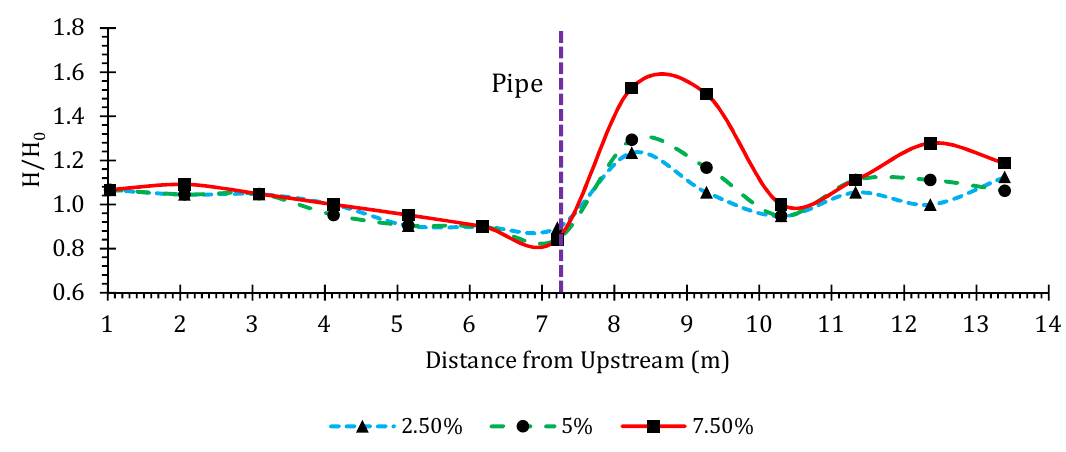
Figure A39. Water height ratios in a 90° junction for Fr = 2.32 in the narrow channel.